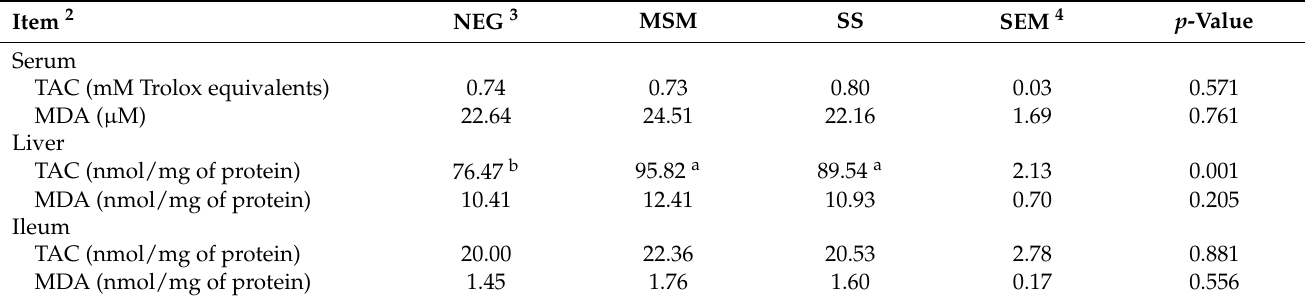
Table 6. Effect of dietary sulfur sources on antioxidant parameters in broiler chickens at 21 d of age 1